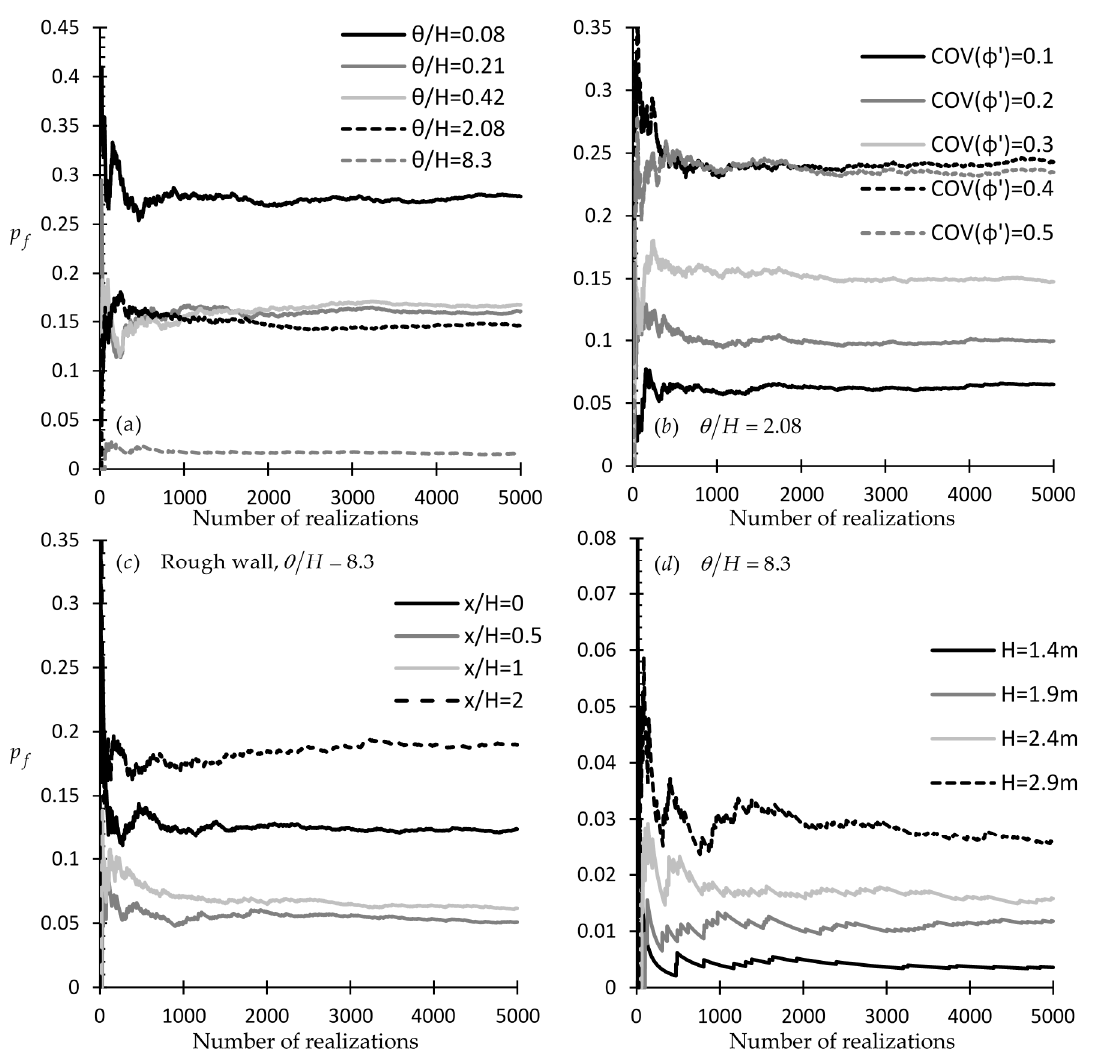
Figure A1. p f versus number of realizations charts for di ff erent ( a ) scale of fluctuation values, ( b ) COV values of φ (isotropic field), ( c ) x / H values and ( d ) wall heights; if not mentioned otherwise, figures Figure A1 . f p versus number of realizations charts for different ( a ) scale of fluctuation values, ( b ) referring to sampling from x / H = 0.5 and d p / H = COV values of φ (isotropic field), ( c ) x H values and ( d ) wall heights; if not mentioned otherwise, figures referring to sampling from x H = 0.5 and d p H = 0.667.